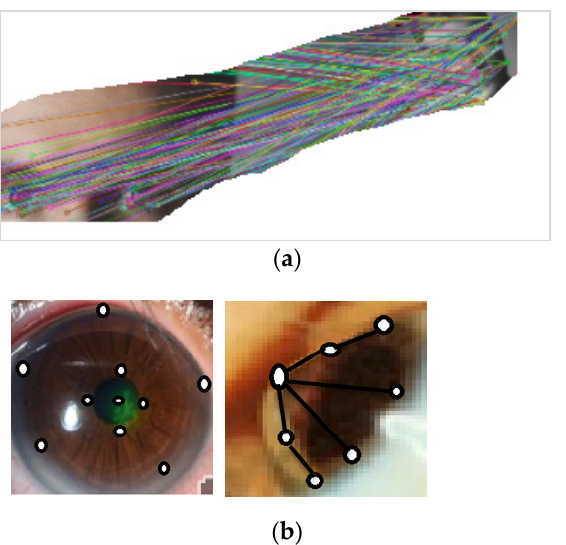
Figure 5. ( a ) Example of the output of the scale-invariant feature transform (SIFT) algorithm. ( b ) Dense features extraction.